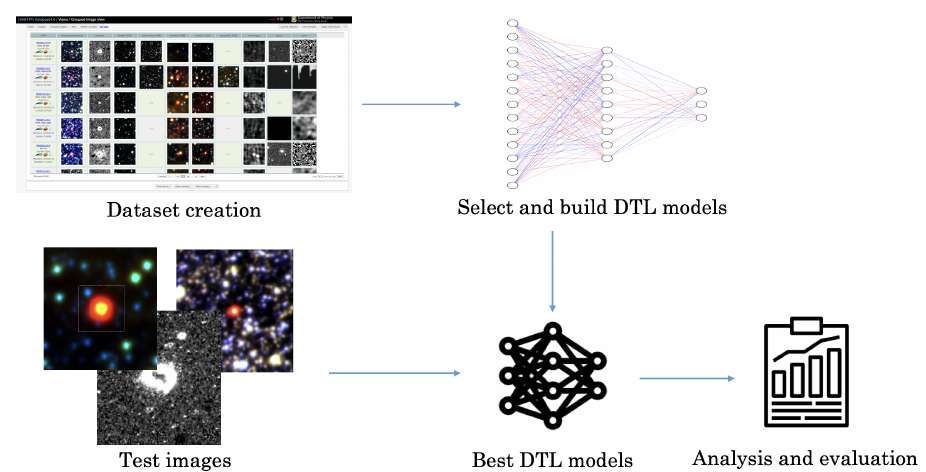
Figure 3. The framework for deep transfer learning for True PNe, Rejected and morphological classifications. The images shown are from the HASH